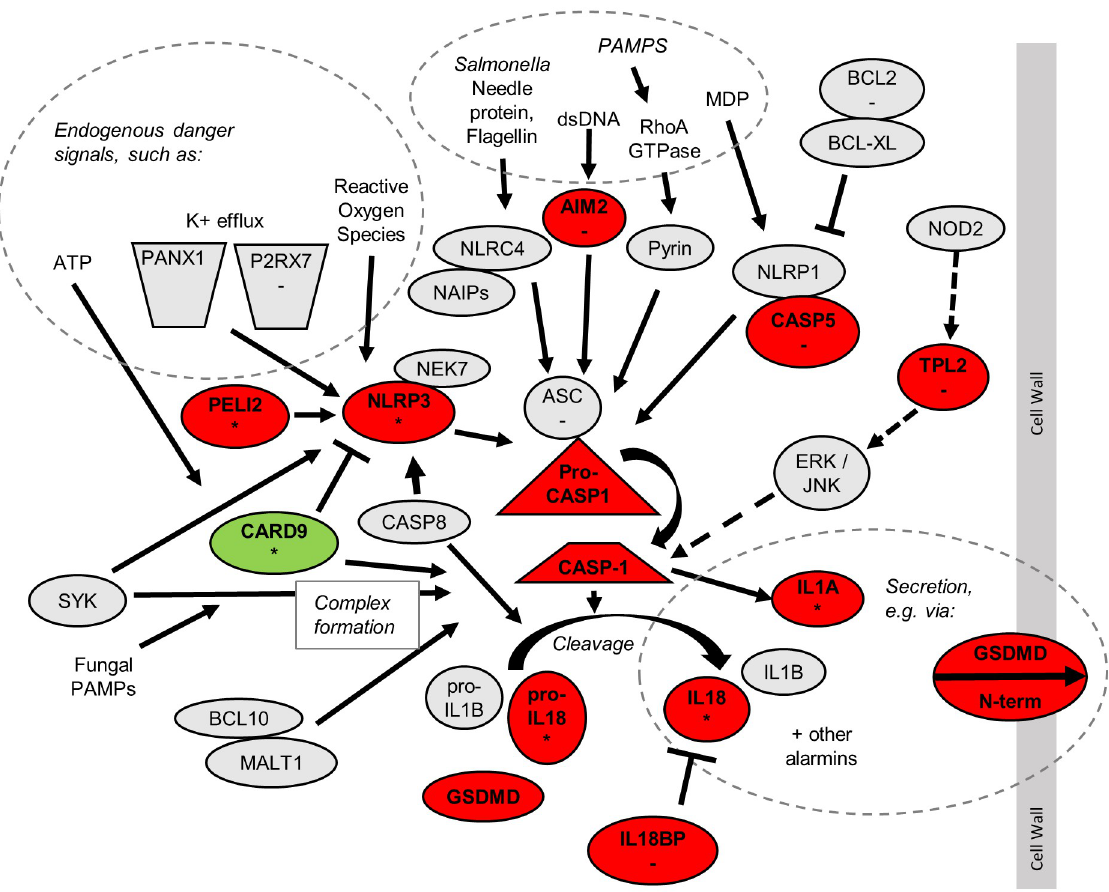
Fig 4. Inflammasome signaling pathways showing genes dysregulated between differently polarized MDM that are infected with Salmonella . Genes upregulated in infected M1 vs. infected M2 macrophages are in red. Genes downregulated in infected M1 vs. infected M2 macrophages are in green. Genes that dysregulated in M EP compared to M2 macrophages in the same direction as in M1 vs. M2 macrophages are indicated with “ � ”. Genes downregulated in M EP vs. M1 macrophages are indicated with